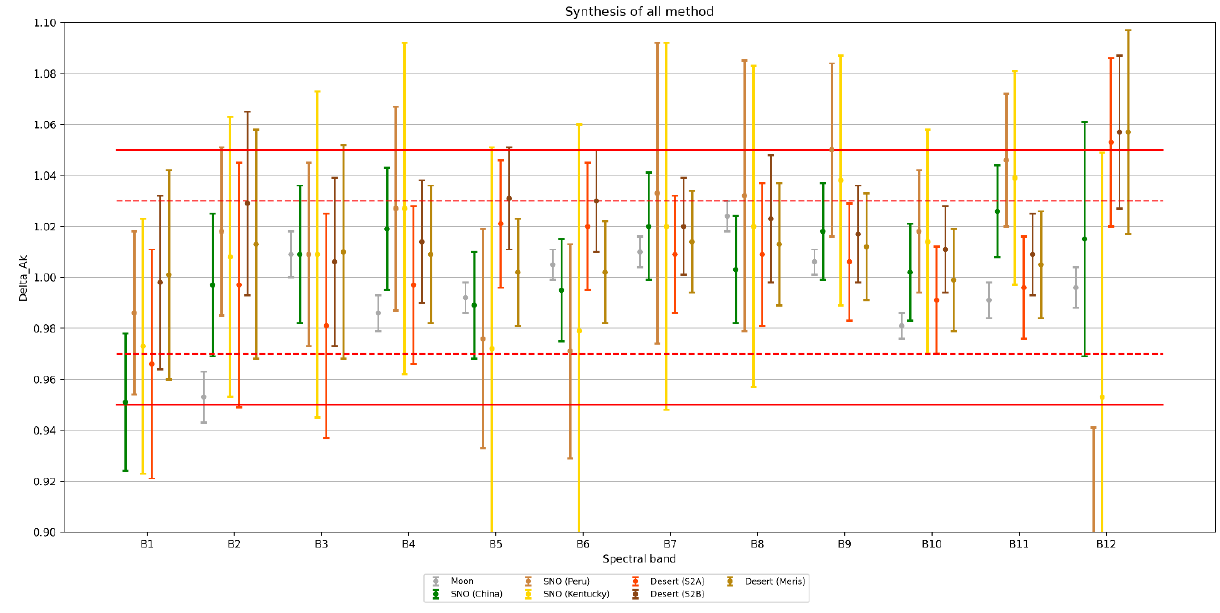
Figure 10. Synthesis of the results computed for the 3 absolute calibration methods used for all spectral bands relative to the operational absolute coefficient.